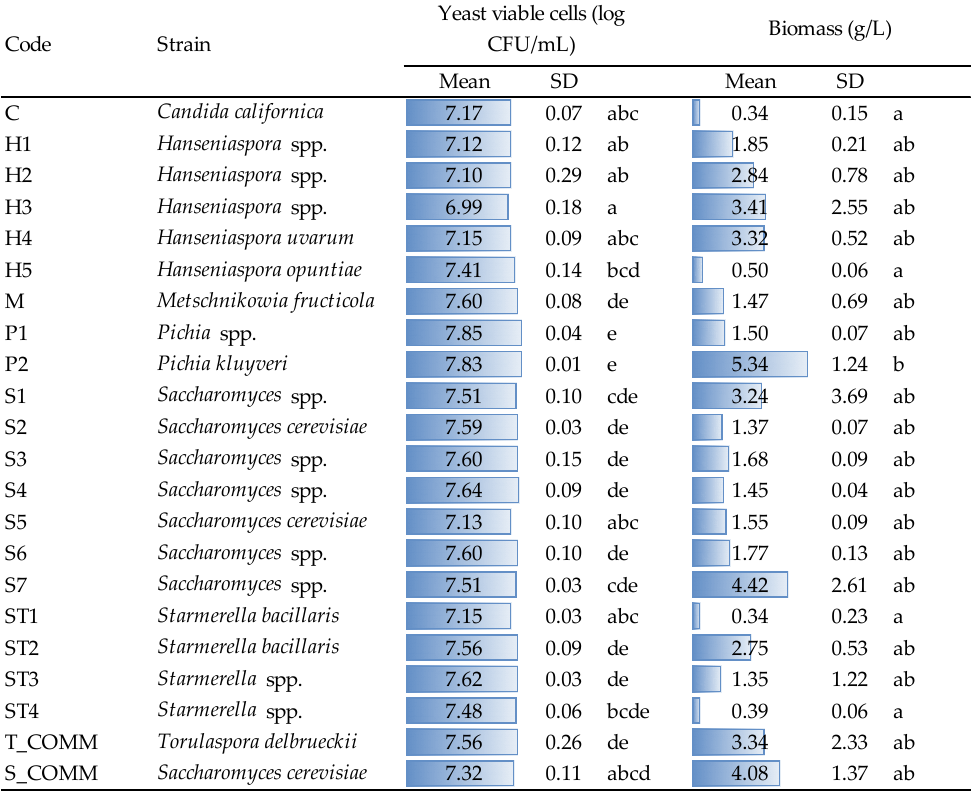
Figure 1. Viable yeast cells and biomass collected for the different stains after growth (48 h in YPD broth, 30 °C). Data are means and standard deviations (SD) of three repetitions. Different letters mark significant differences according to ANOVA and Tukey HSD test at p < 0.05. T_COMM, S_COMM: commercial active dry yeast preparations.